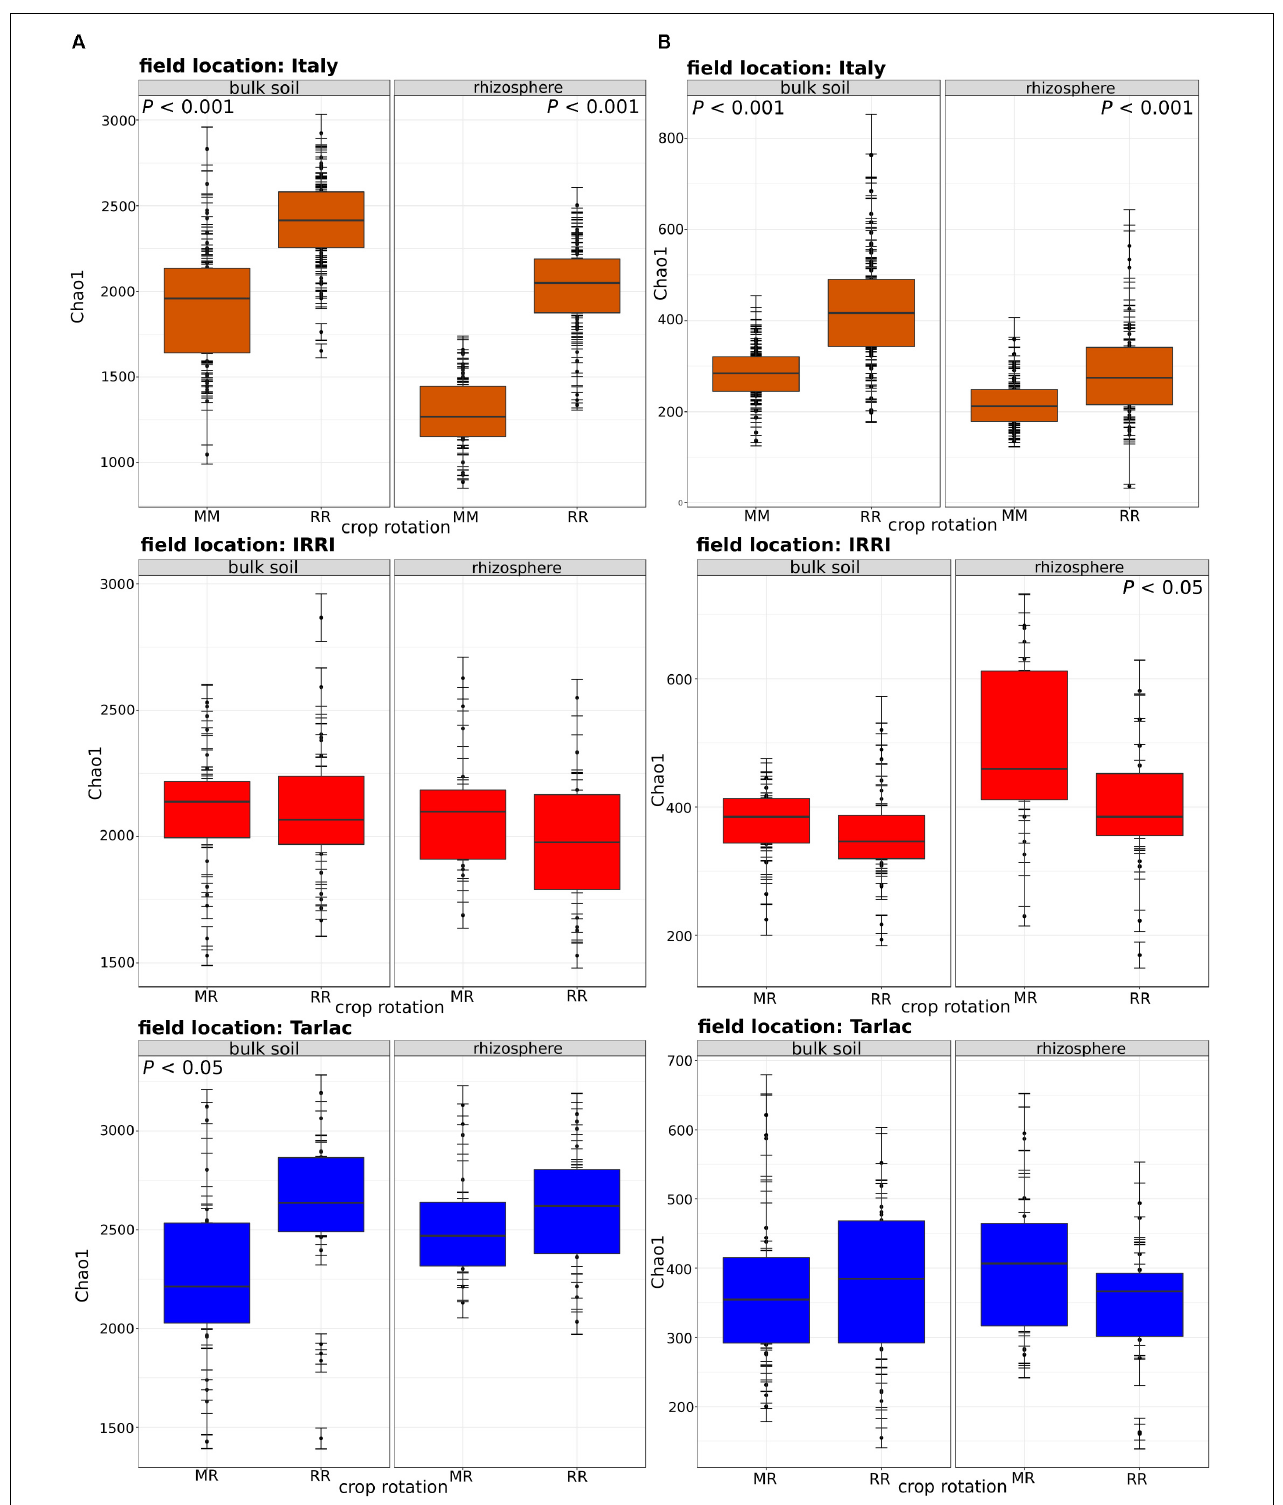
FIGURE 2 | Box plots showing the influence of crop rotation on bacterial (column A ) and fungal alpha diversity (column B ) within each field location and compartment. Each box plot shows alpha diversity based on the Chao1 diversity index and includes all samples treated with or without straw and collected at different time points. The median as well as the 25 th and 75 th percentile of the samples is presented, individual data points outside of this range are given as mean ± standard deviation of four replicate samples. Significant differences due to crop rotations within one compartment (bulk soil or rhizosphere) are noted.